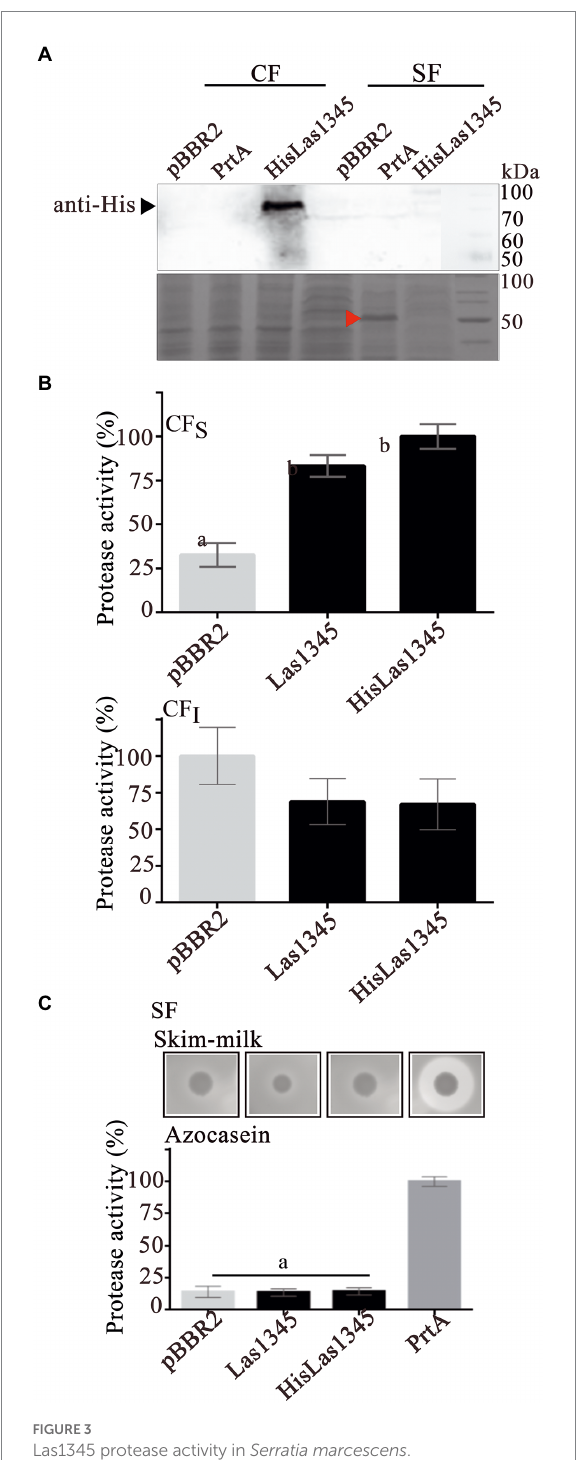
FIGURE 3 Las1345 protease activity in Serratia marcescens . (A) Immunodetection of Las1345 (~75 kDa) in cellular (CF) and supernatant cell free fraction (SF) prtA cells from S. marcescens expressing Las1345, HisLas1345 or transformed with an empty vector (pBBR2), grown for 16 h at 30 ° C. PrtA (~50 kDa) was visualized by Coomassie staining (red arrow) and used as control of extracellular secretion (SF). (B) Protease activity in soluble and insoluble CF (CF S and CF I ) from prtA /pBBR2, prtA /Las1345, prtA